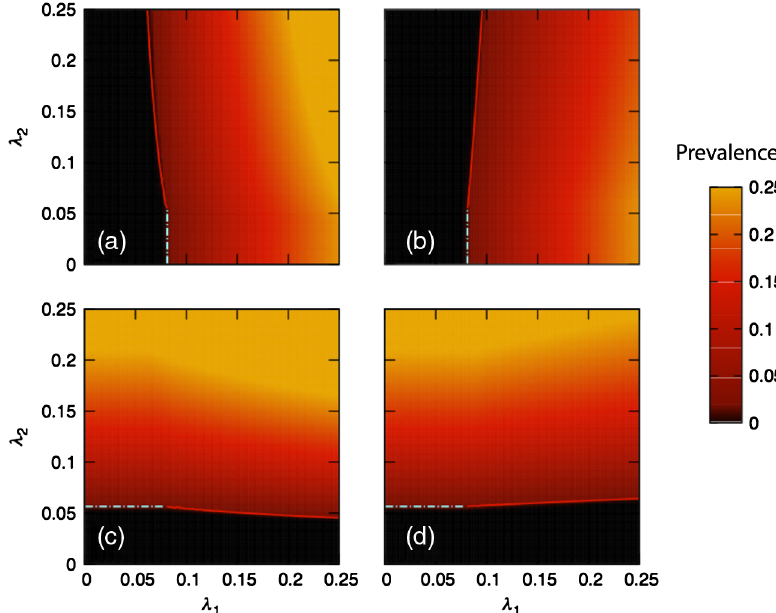
FIG. 4. (a),(c) Reciprocally enhanced spreading with β a 1 ¼ β b 1 ¼ β a 2 ¼ β b 2 ¼ 1 . 3 , η 1 ¼ η 2 ¼ 0 . 8 , represented at the final stationary state. (b),(d) Reciprocally impaired spreading β a 1 ¼ β b 1 ¼ β a 2 ¼ β b 2 ¼ 0 . 8 , η 1 ¼ η 2 ¼ 1 . 3 , also at the final state. Scale-free networks are generated using the uncorrelated configuration model with N 1 ¼ N 2 ¼ 5000 agents, h k i ¼ 4 . 00 , and h l i ¼ 5 . 11 . The figure represents the final prevalence of (a),(b) disease 1 and (c),(d) disease 2 in each